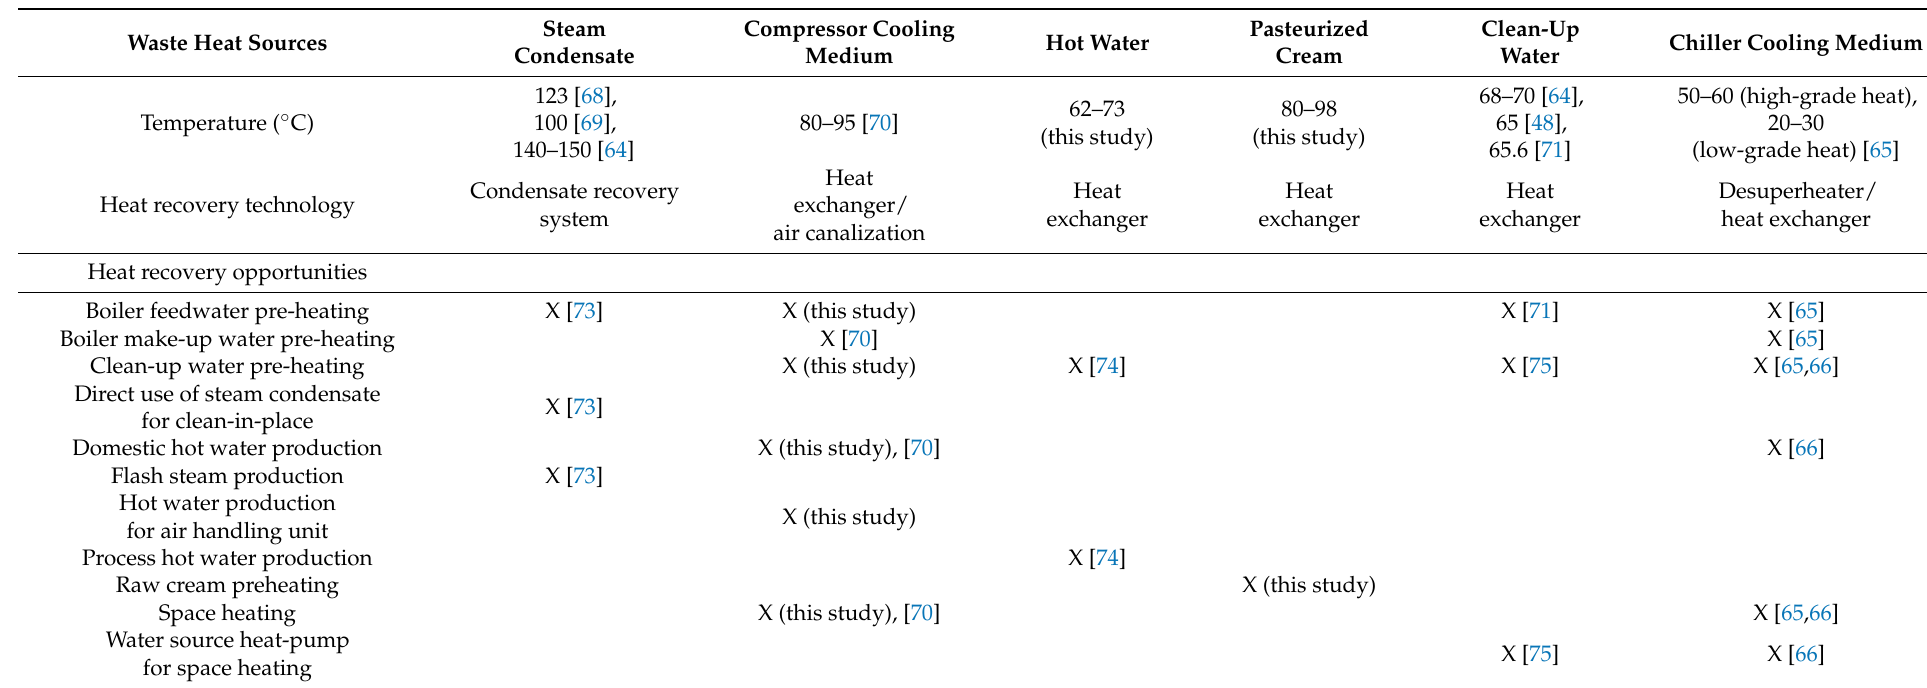
Table A4. Scheme providing the characterization of waste heat sources from pasteurized cream production and the identification of possible heat